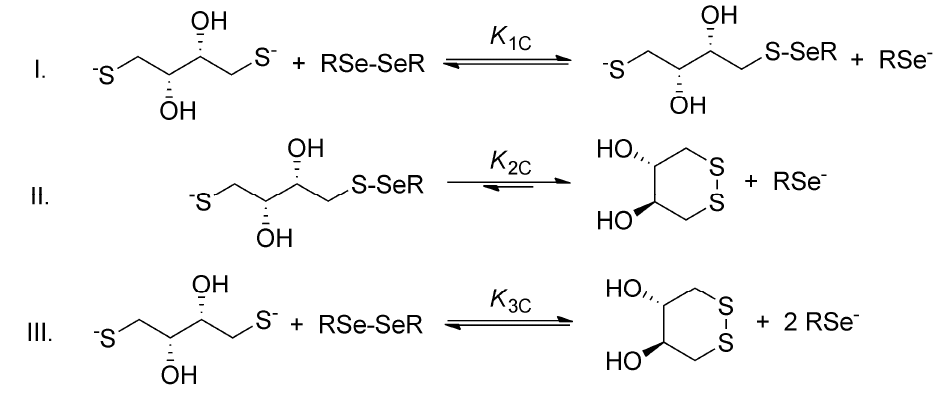
Figure 3. The two-step redox equilibria between a diselenide compound and DTT 2 − (reaction I and II) followed by their aggregated one-step net reaction (III). Identical reaction schemes are applicable for disulfide analogues. The arrow in reaction II indicates the low probability of formation of the sulfur– selenium bridge.